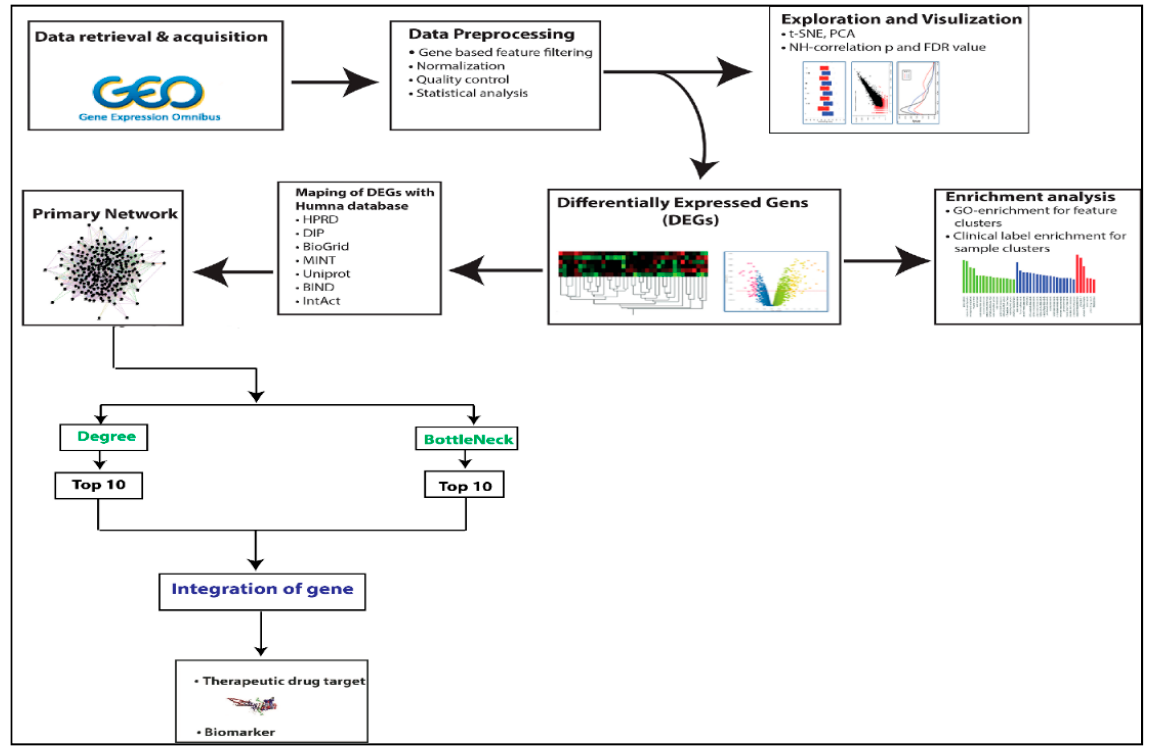
Figure 1. The workflow of the methodologies used in the study of the C. parvum infection-related PPI network is depicted in this diagram.